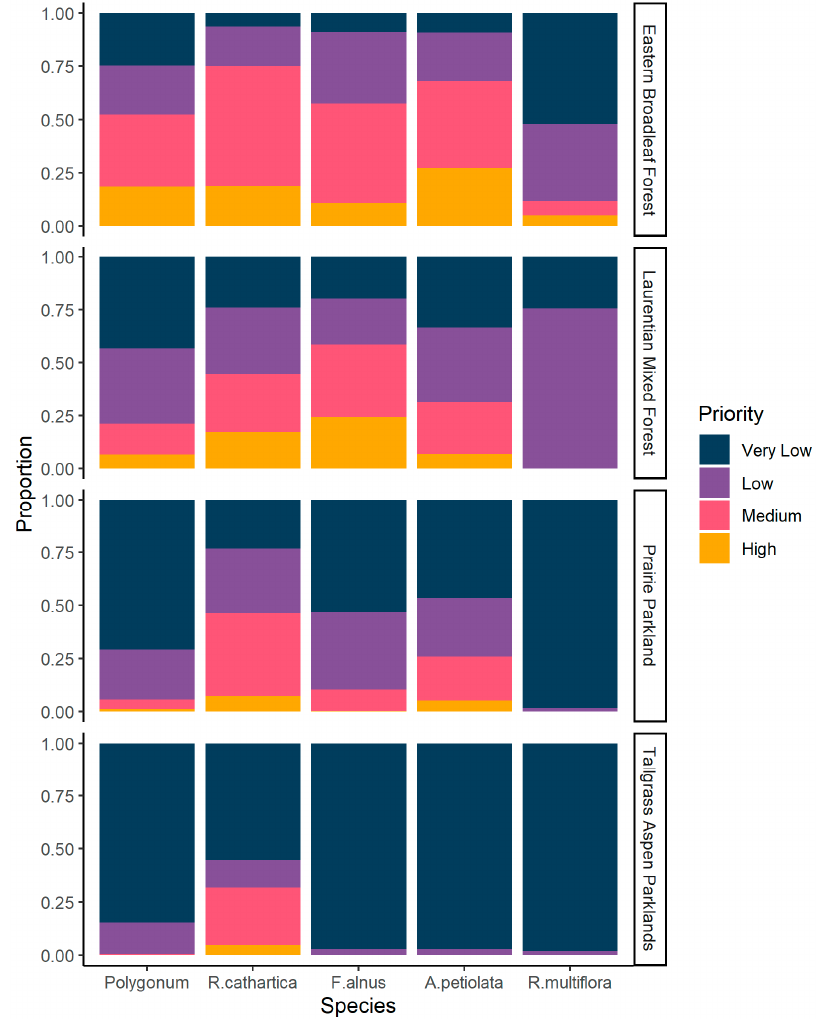
Figure 3. Distribution of priority classes across ECS Provinces by species. Warmer colors represent higher priority classes.